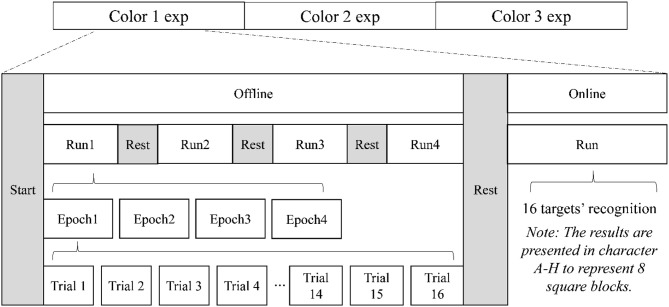
Flowchart of our experiments (note: exp here stands for experiment).